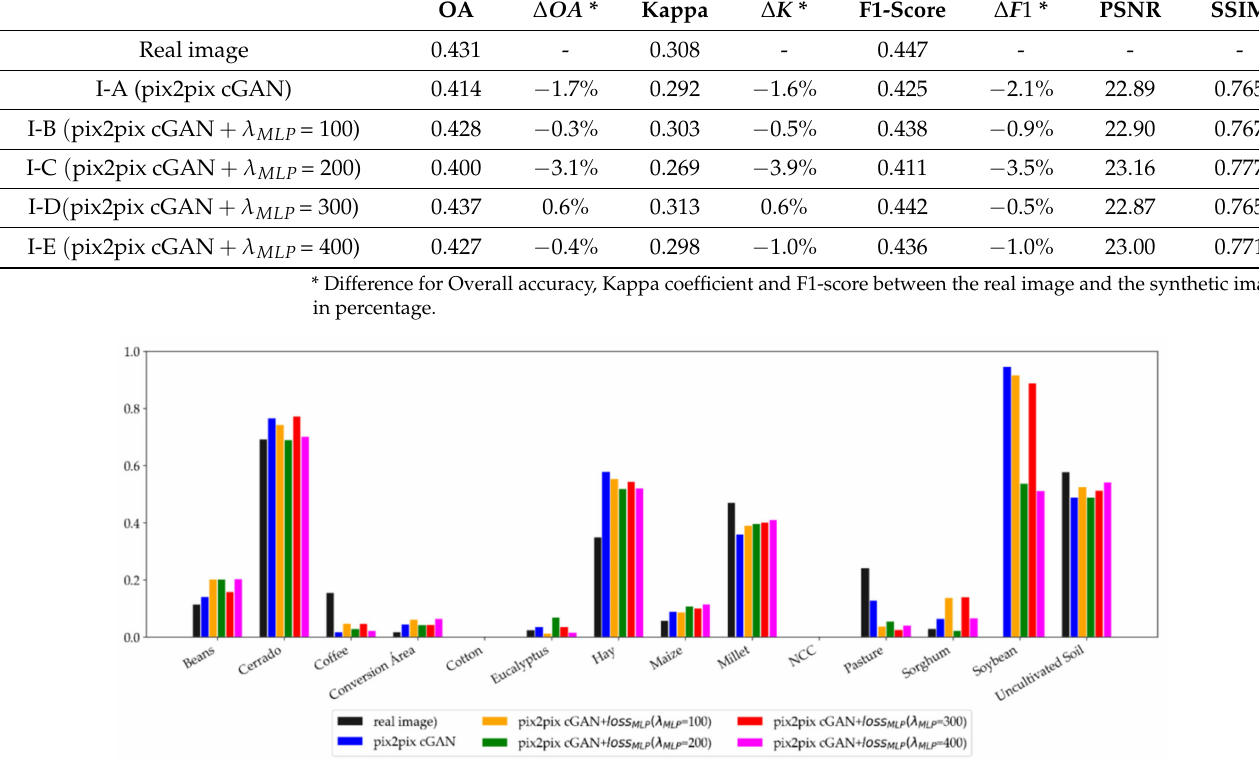
Figure 9. F1-score for the semantic classification in the real and generated